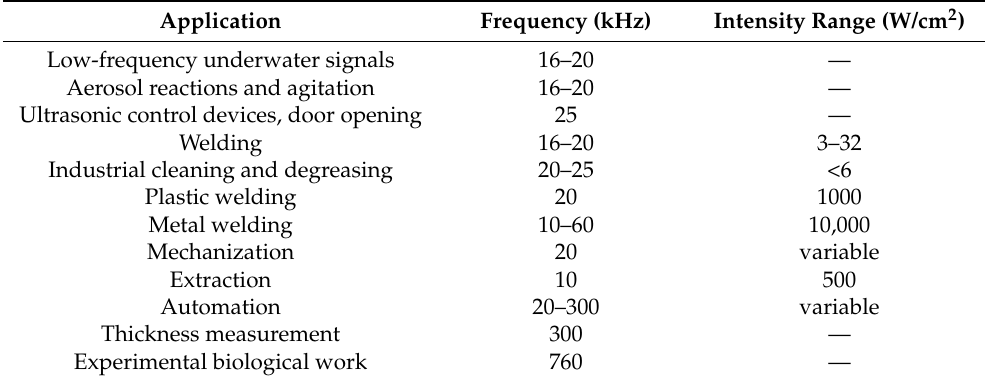
Table 1. Ultrasound applications. NTP 205: Ultrasound: occupational exposure. (INSHT, 1985) [2].